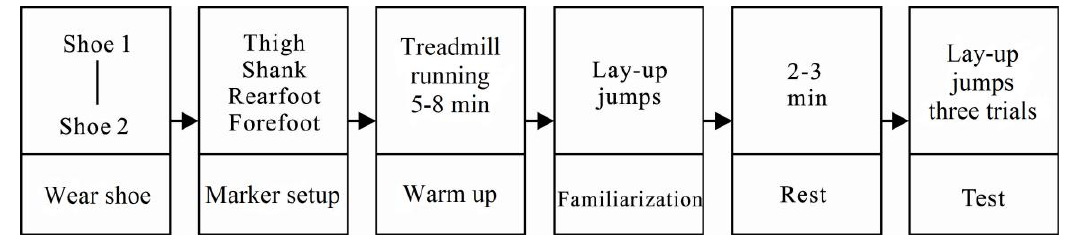
Figure 2. Testing procedure.